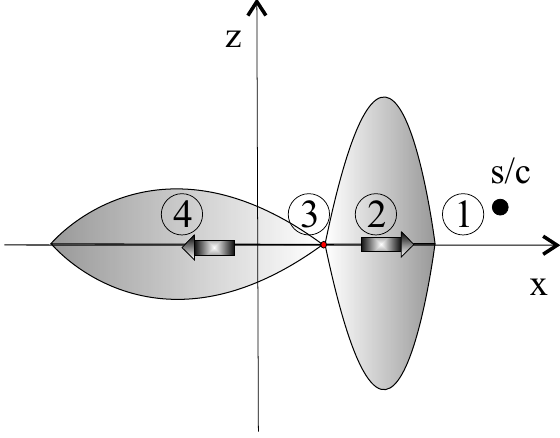
Fig. 11. Spacecraft in the vicinity (region 1) of a reconnection event. The shaded regions denote the outflow regions and the arrows show the direction of the accelerated plasma. The X–line moves right- wards. In the course of time, the spacecraft gets passed by regions 1–4, measuring different plasma and magnetic field conditions in each region.